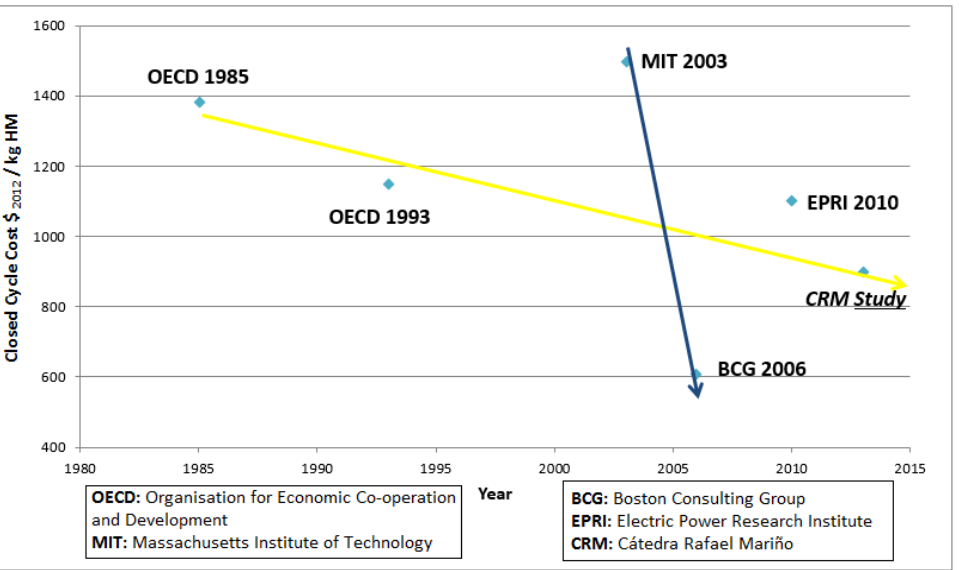
Figure 2. Closed cycle evolution cost.